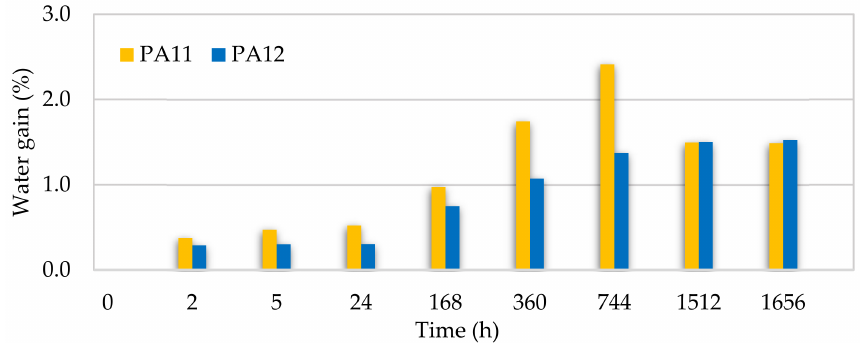
Figure 14. Water gain of PA11 and PA12 at different aging times.